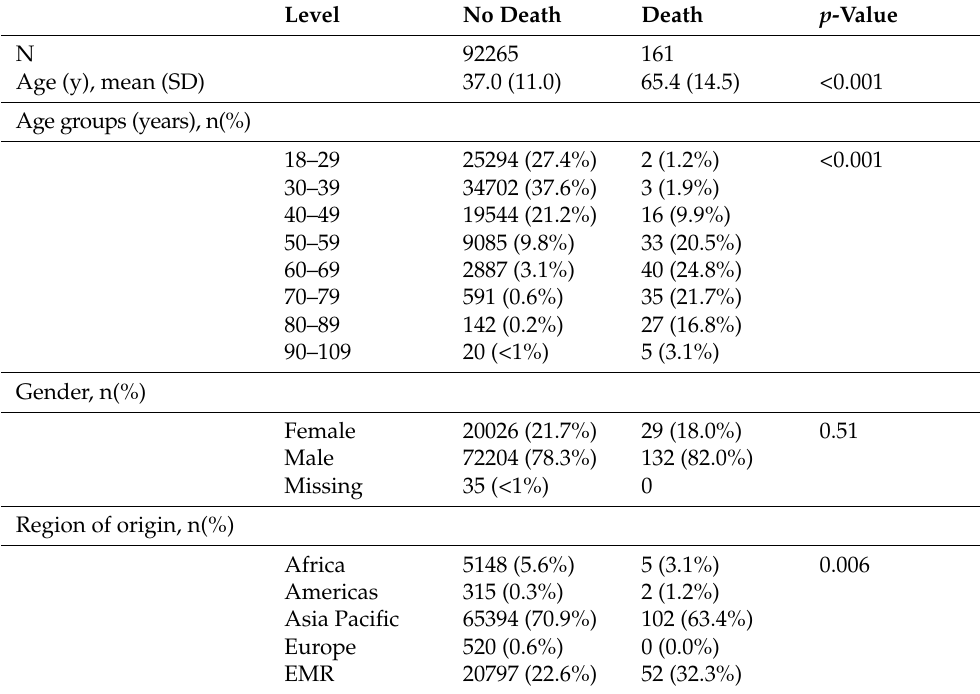
Table 1. Description of the